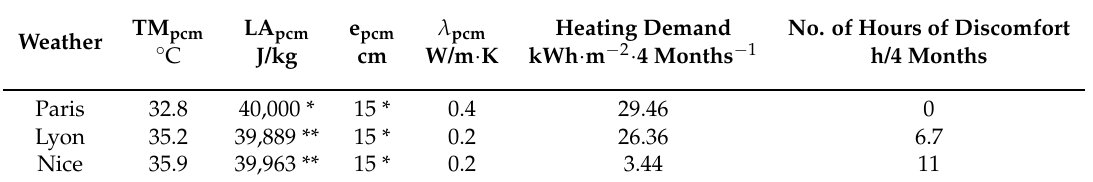
Table 8. Optimal parameters for the three weather conditions (optimization of the number of hours of discomfort objective